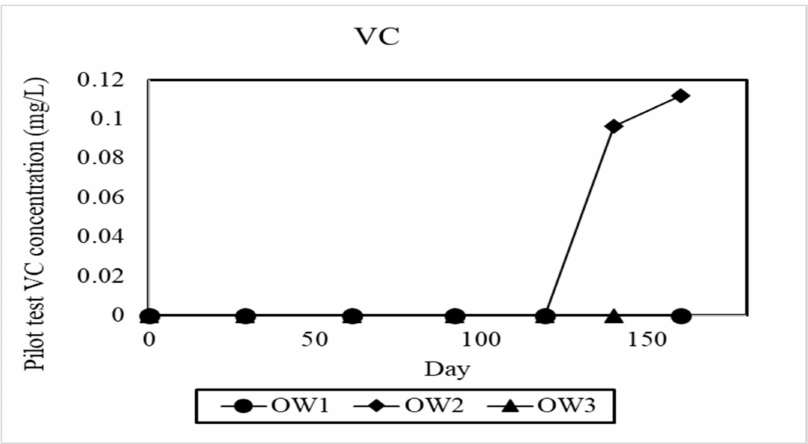
Figure 9. VC concentration variation of each monitoring well in the in situ field